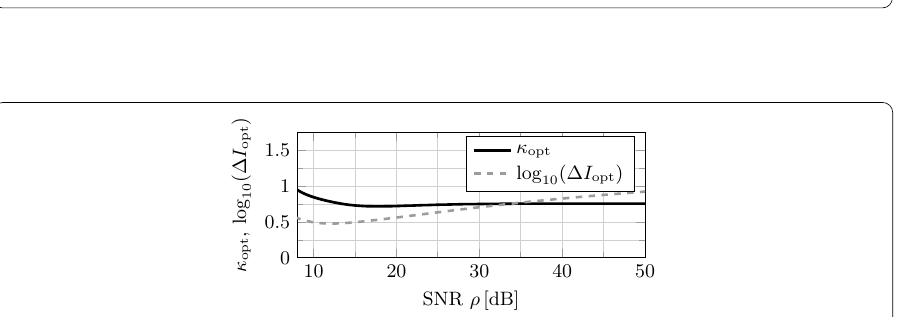
Fig. 5 Transformation from amplitude noise z ( T ′ k ) to shift error S k for an SNR of 10 dB. In the transition interval [ T k , T k + β ] , the transmitted signal is represented by the filtered transmit waveform ˆ f ( t )